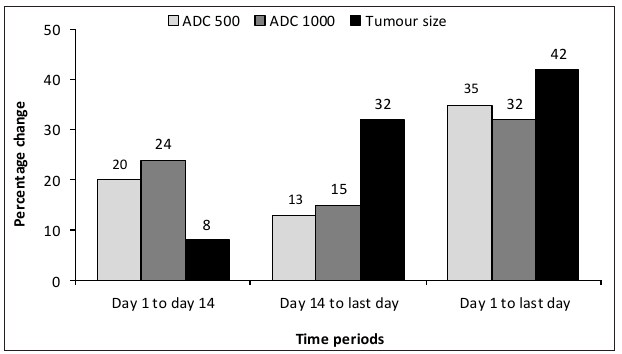
Fig. 2. Percentage change in ADC 500 and ADC 1 000 values and tumour size during different periods of the